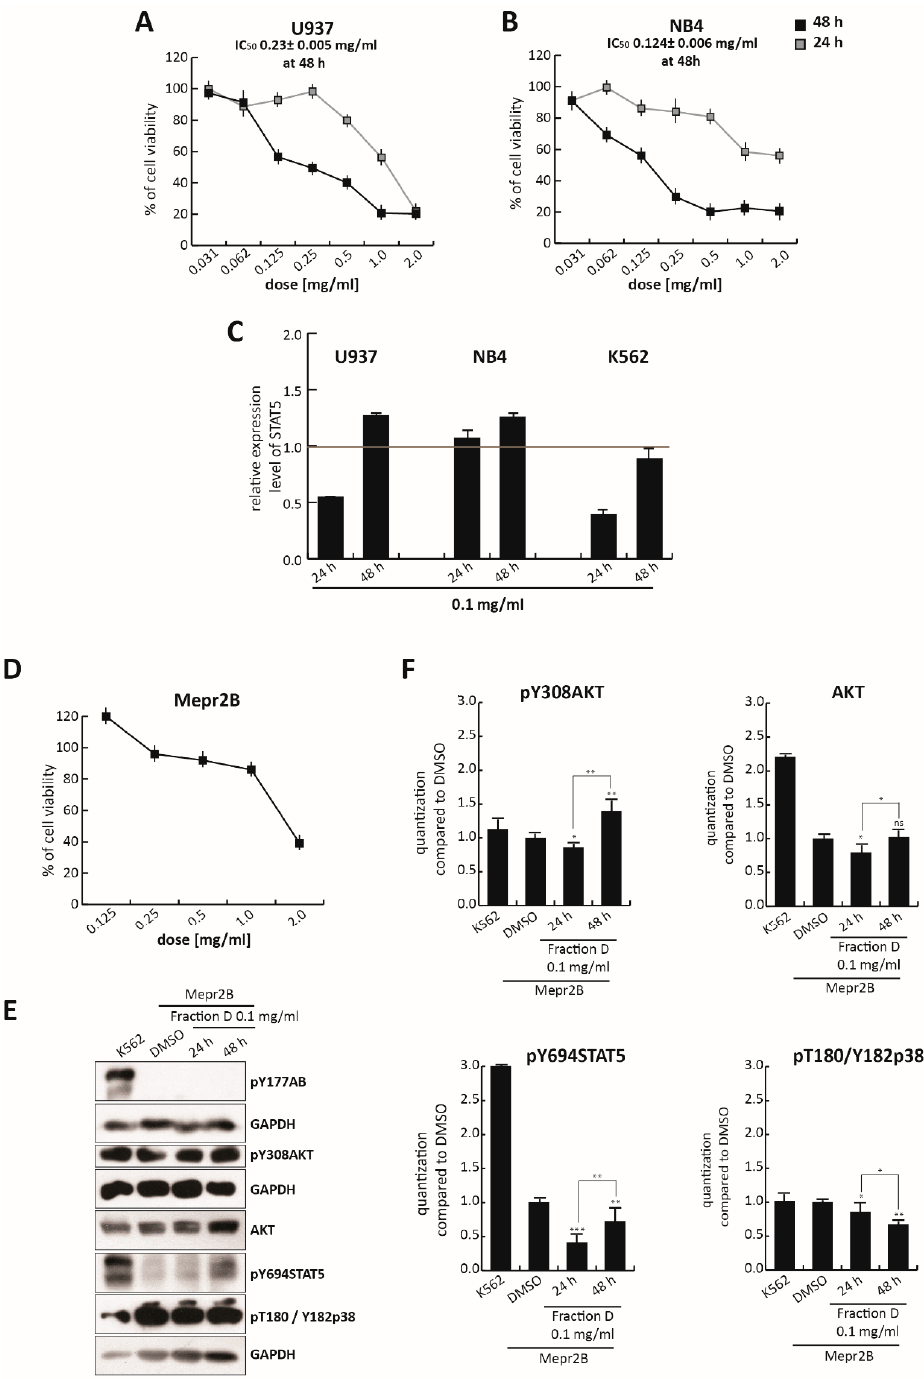
Figure 6. Effect of Fraction D in leukemia and normal cell lines. Cell growth rates determined by MTT of ( A ) U937 and ( B ) NB4 cells treated with Fraction D for 24 and 48 h, at the indicated concentrations, and of ( D ) Mepr2B cells challenged with Fraction D for 48 h, at the indicated concentrations. ( C ) STAT5 gene expression analysis of U937, NB4, and K562 cells treated with Fraction D at 0.1 mg/mL, for 24 and 48 h. Values are mean ± SD of biological triplicates. ( E ) pY177AB, pY694STAT5, pY308AKT, AKT, and pT180/Y182p38 expression levels in Mepr2B cells treated with Fraction D at 0.1 mg/mL for 24 and 48 h. ( F ) Normalization of protein level expression by the ImageJ software. Values are mean ± SD of biological duplicates. **** p -value ≤ 0.0001, *** p -value ≤ 0.001, ** p -value ≤ 0.01, * p -value ≤ 0.05, ns p -value > 0.05 vs. control